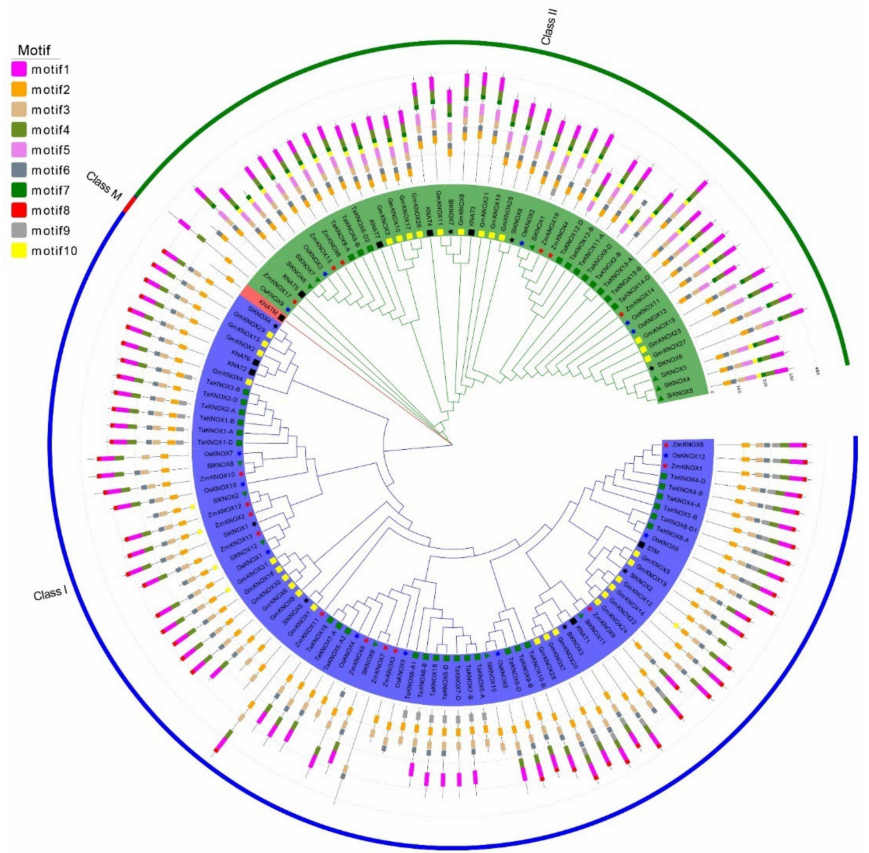
Figure 2. Phylogenetic tree of KNOX proteins constructed using the maximum-likelihood (ML) phylogenetic tree by MEGA X. In total, 126 KNOX genes from different species were used to construct the phylogenetic tree by MEGA X. The three different groups are indicated by different colors. Different species are indicated by different shapes and colors. 10 motifs are predicted by MEME and different colored boxes represent different motifs. The box lengths represent motif